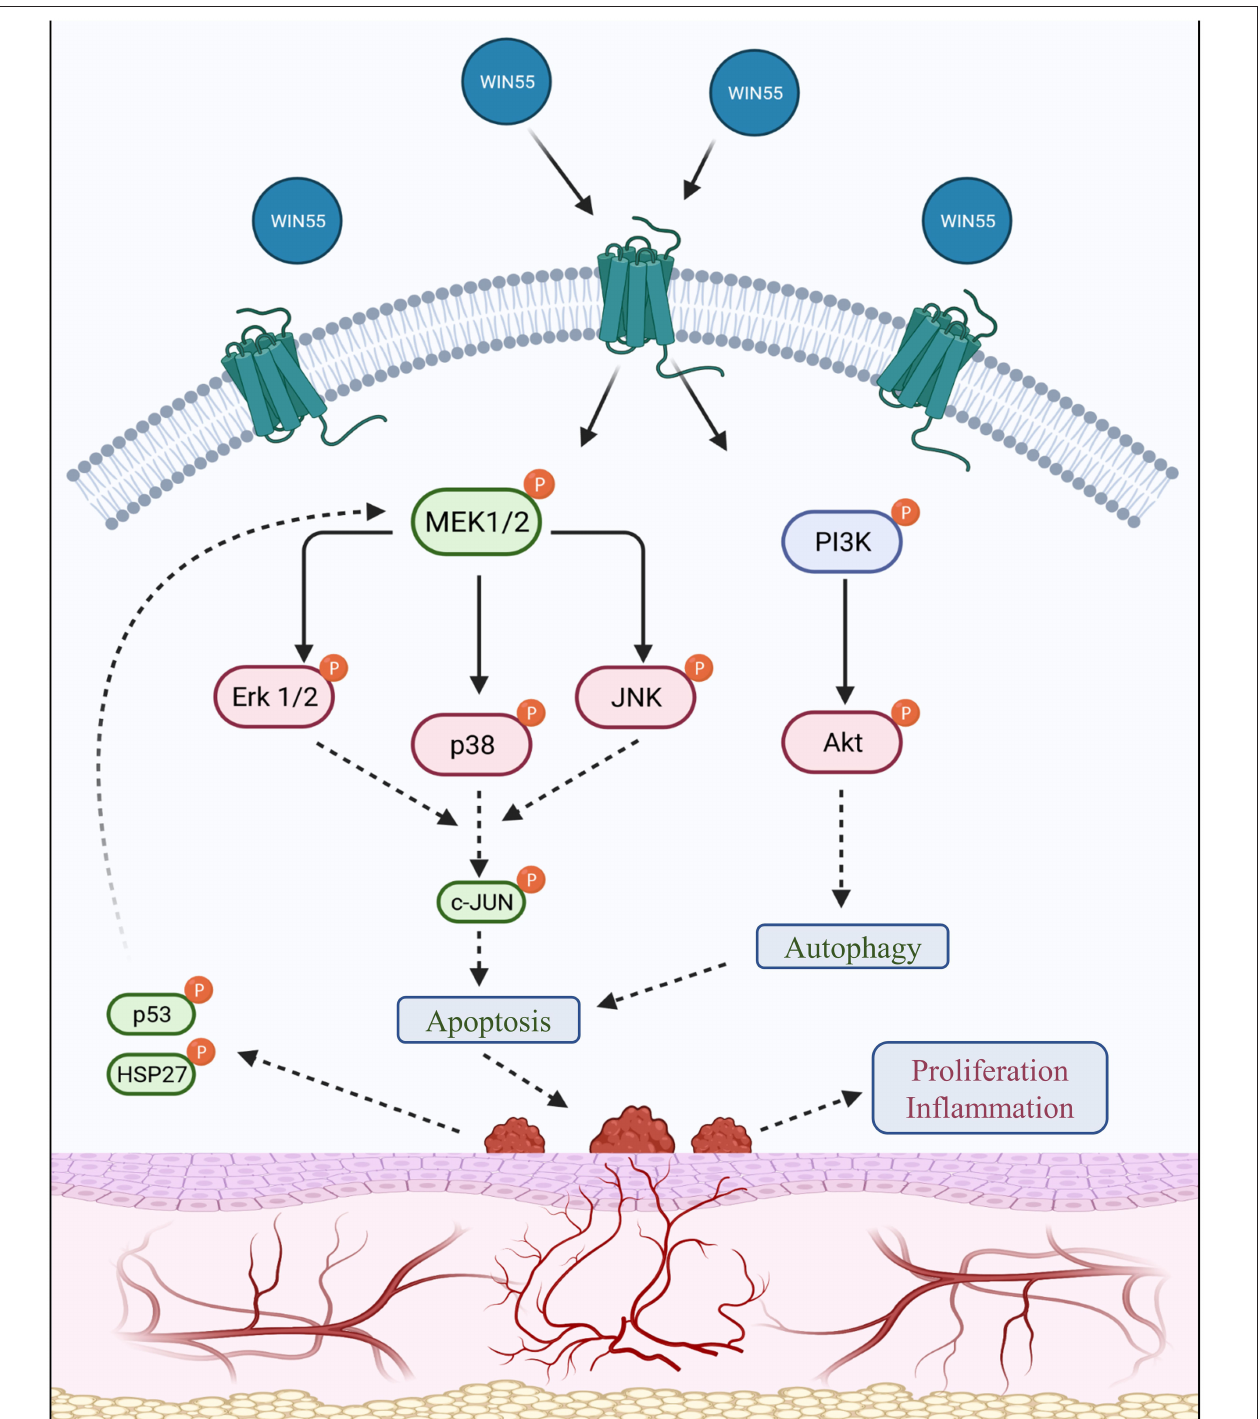
FIGURE 6 | Summary of the signaling cascade triggered by cannabinoid receptor activation in endometriosis. A summary of the downstream signal alteration upon cannabinoid receptor activation is outlined in this schematic representation. Protein kinases, such as MAPK (p38) and PI3K/Akt family members, are involved in cell growth, migration, and survival under normal circumstances. Endometrial tissues have been identified to possess higher activity of kinases such as MAPK and Akt, which contribute to increased proliferation. Protein levels assessed in this study show that CB1 and CB2 receptor activation by WIN 55 leads to downstream modulation of important MAPK family proteins, such as Erk 1/2, p38, JNK, c-JUN, p53 and HSP27, as well as PI3K/Akt axis to trigger autophagy and eventually apoptosis through caspase-dependent and/or independent pathway. The use of red and green colors within the labeling represents downregulation and upregulation,